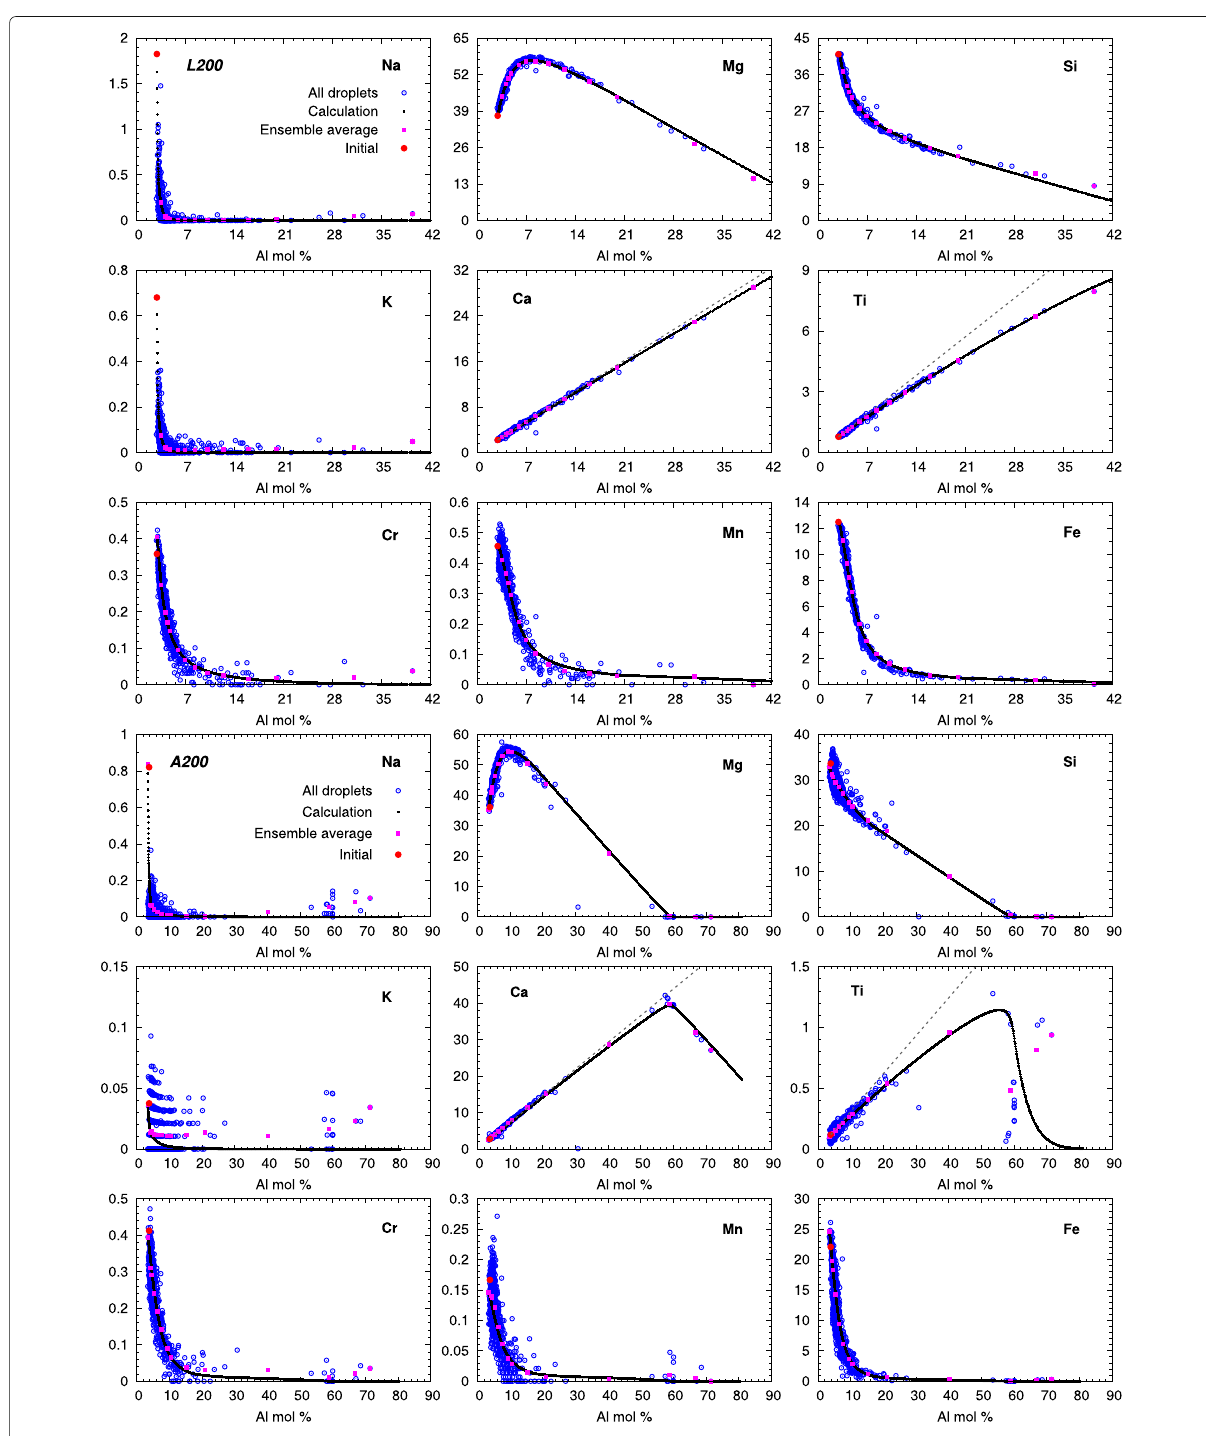
Fig. 6 Element concentration in mol% in the droplets as a function of Al mol% for the experiment groups L200 and A200. ‘All droplets’ indicate all of the droplets analyzed for each group. The ‘Initial’ composition is either L sil for L200 or Allende for A200. For ‘Ensemble average’, refer to “Derivation of relative volatilities from the experimental results” section and Table 4. ‘Calculation’ denotes the calculated composition of the MLB that evolves by evaporation,startingwiththeinitialcomposition,eitherofL sil orofAllende.See“ApplicationofrelativevolatilitiestoanarbitraryMLB:self-consistency test” section for detail. The dotted lines in the Ca and Ti panels indicate extension of the lines that connect the origin and their initial